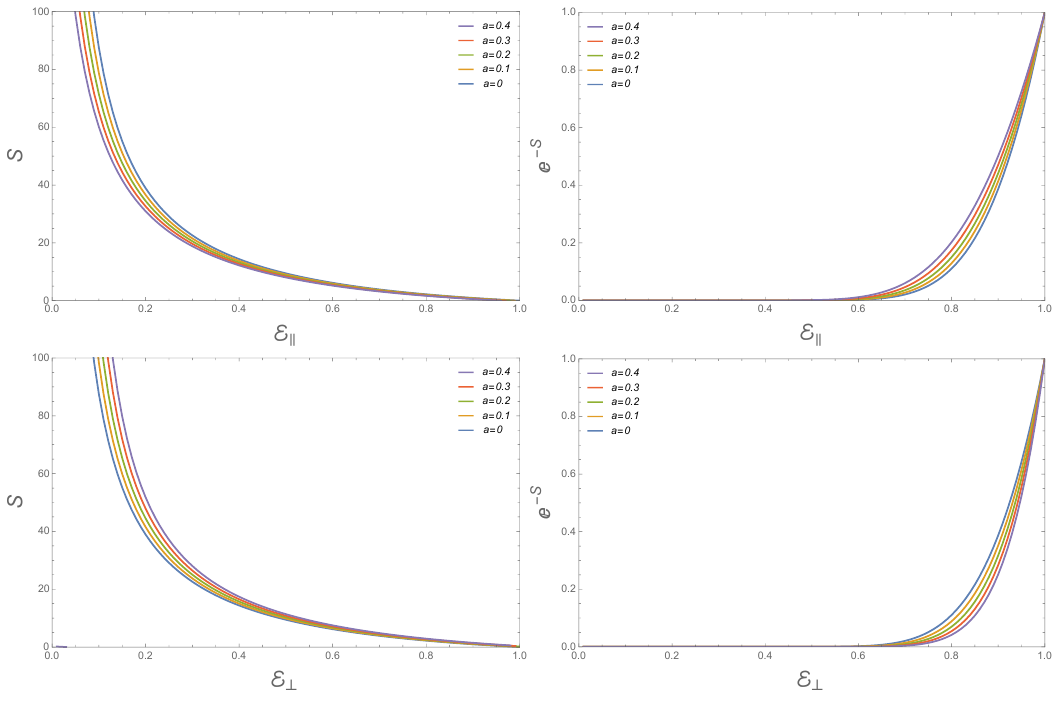
Figure 9 . The production rate as a function of E